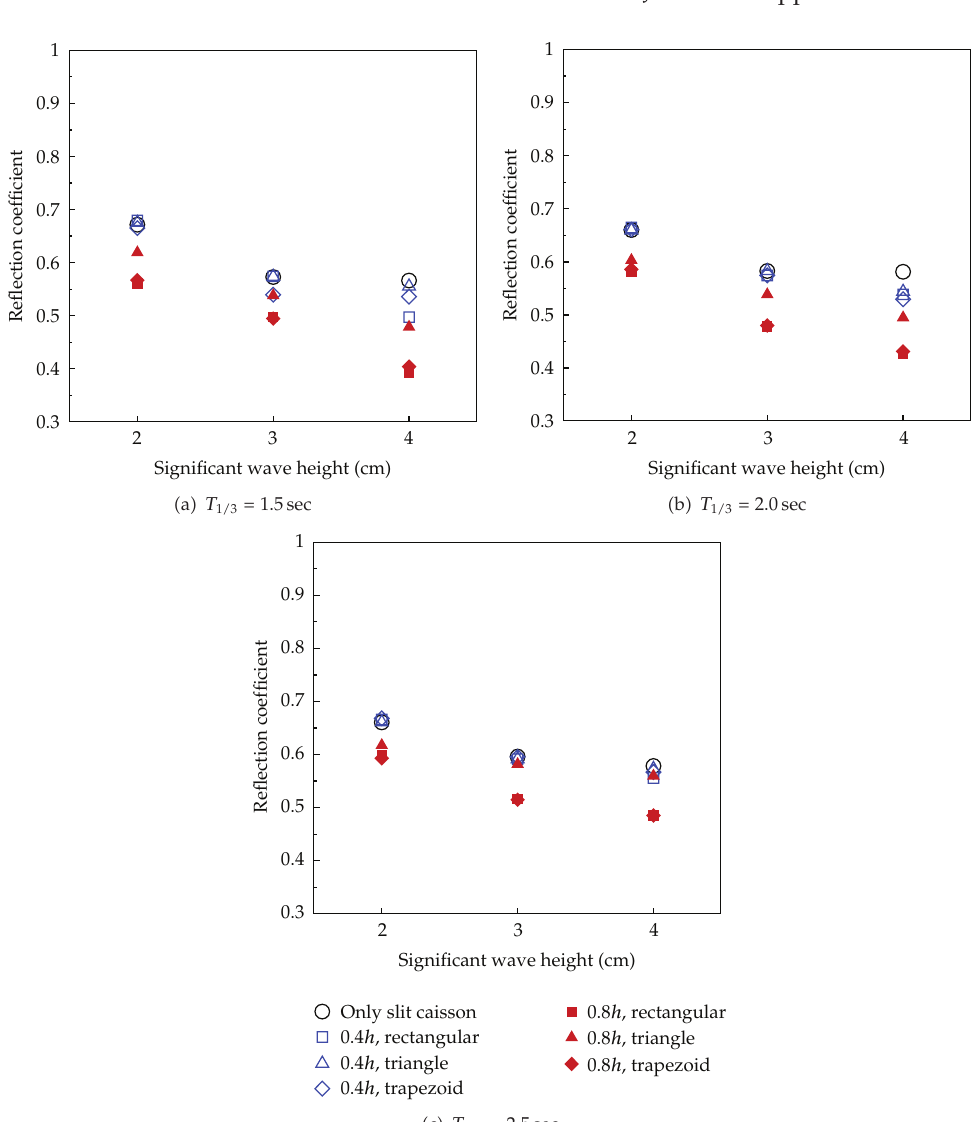
Figure 4: Reflection coe ffi cient for slit caisson with di ff erent significant wave